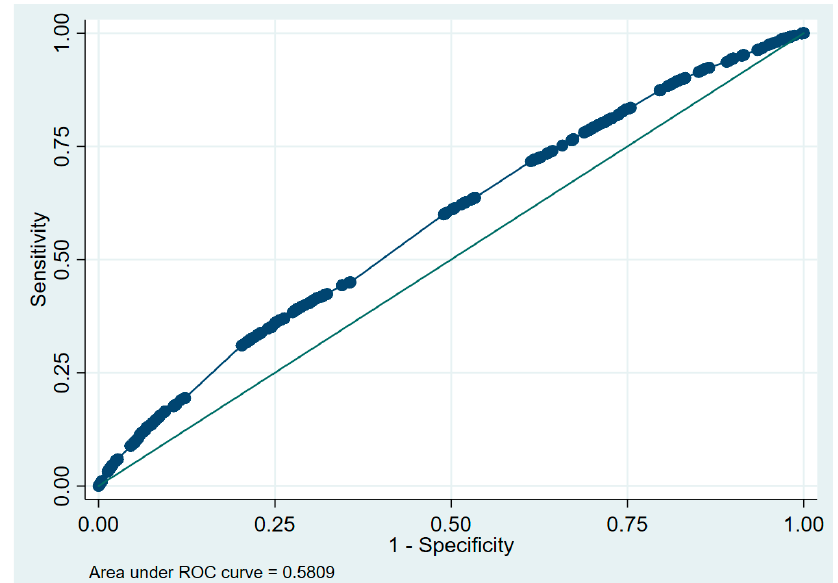
Figure 5. The ROC curve for the first model.